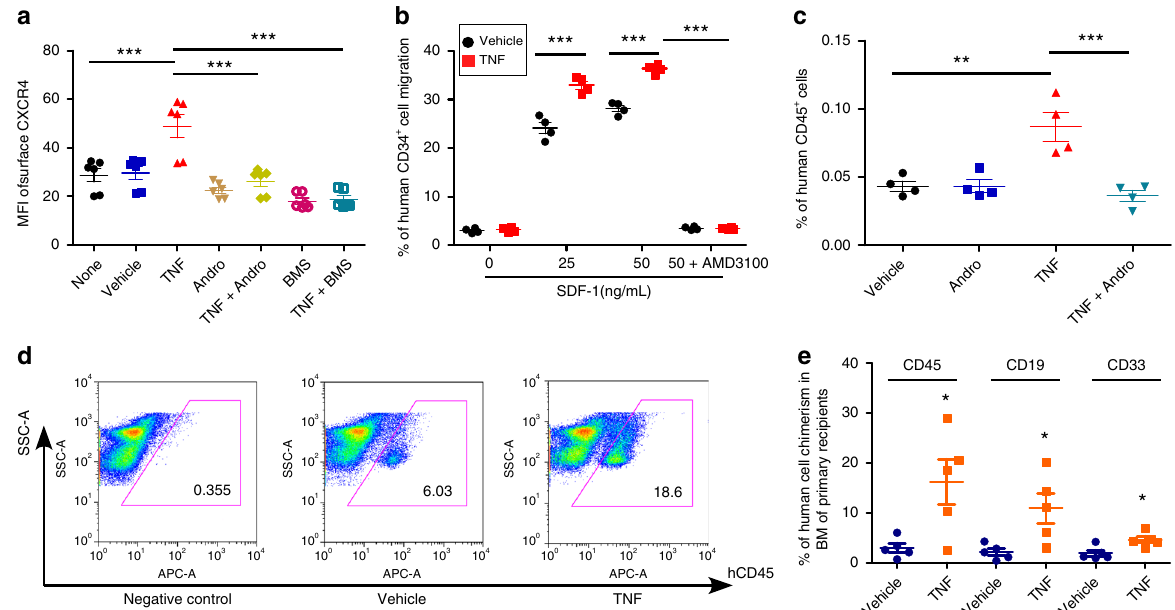
Fig. 8 TNF α treatment results in signi fi cantly enhanced HSC homing and engraftment. a Mean fl uorescence intensity (MFI) of surface CXCR4 in vehicle, TNF α (TNF, 100 ng/mL), Andrographolide (Andro)-, TNF + Andro-, BMS345541 (BMS)-, TNF + BMS-treated human CB CD34 + cells, as assessed by fl ow cytometry. None indicates the group without any treatment. Data pooled from three independent experiments are shown ( n = 6, one-way ANOVA, *** p < 0.001). b The cells were cultured in the presence of vehicle or TNF α (TNF, 100 ng/mL) for 16 h and then allowed to migrate toward the indicated concentrations of SDF-1 for 4 h. Vehicle or TNF-treated human CB CD34 + cells migration in the presence of the CXCR4 antagonist, AMD3100 (5 μ g/mL) were also shown. Data pooled from three independent experiments are shown ( n = 3, one-way ANOVA, *** p < 0.001). c The percentage of human CD45 + cells in the BM of NSG mice 24 h after transplantation with 500,000 CB CD34 + cells that had been treated with vehicle, Andrographolide (Andro, 10 μ M), TNF α (TNF, 100 ng/mL), or TNF + Andro. Data pooled from four independent experiments are shown ( n = 4 mice per group, one-way ANOVA, ** p < 0.01, *** p < 0.001). d Representative fl ow cytometric analysis of human engraftment in the BM of NSG mice transplanted with human CB CD34 + cells treated with vehicle control or TNF α (TNF, 100 ng/mL) for 16 h. Human engraftment was assessed as the percentage of human CD45 + cells. e The percentage of